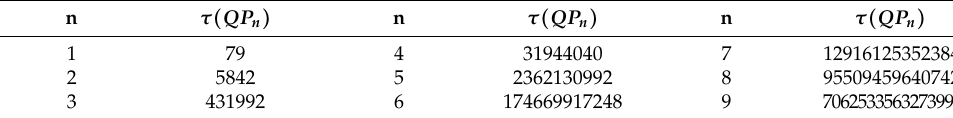
Table 2. The number of spanning trees of linear pentagonal derivation chains from QP 1 to QP 9 .